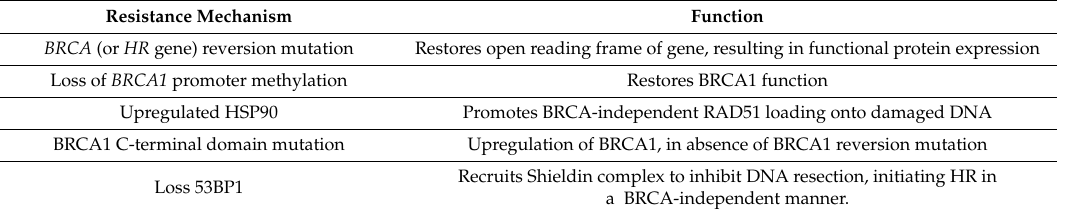
Table 3. Mechanisms of reactivation of Homologous Recombination repair.